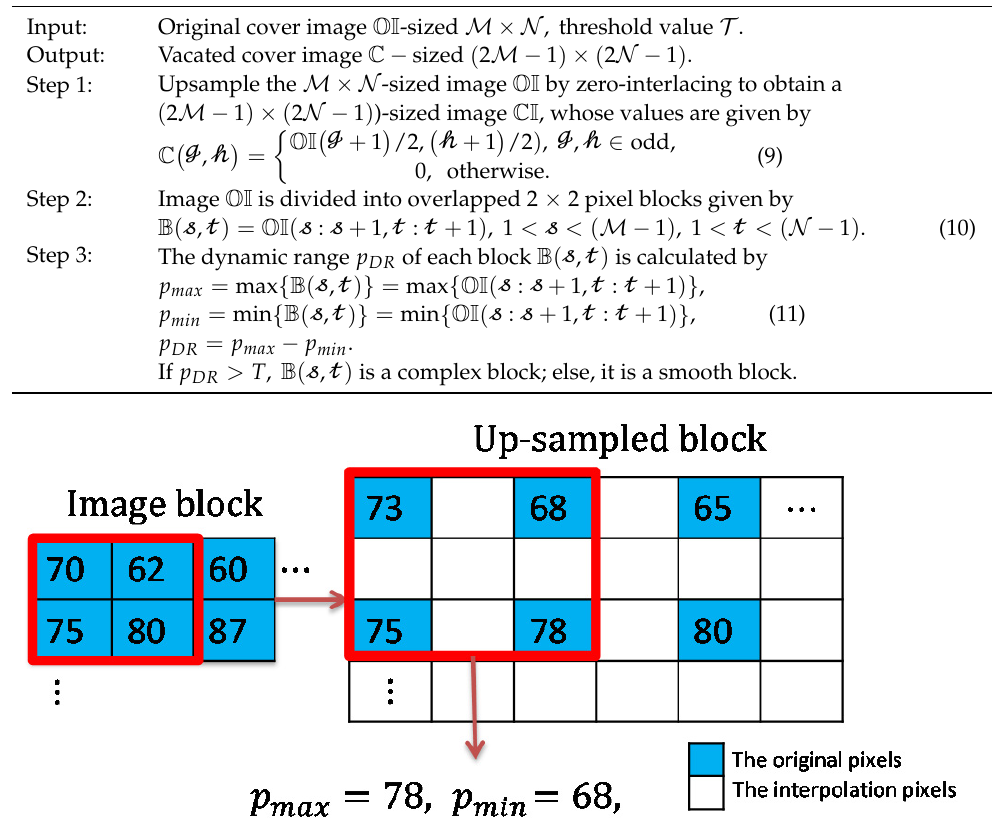
Algorithm 1 Image Upsampling and Block Classification